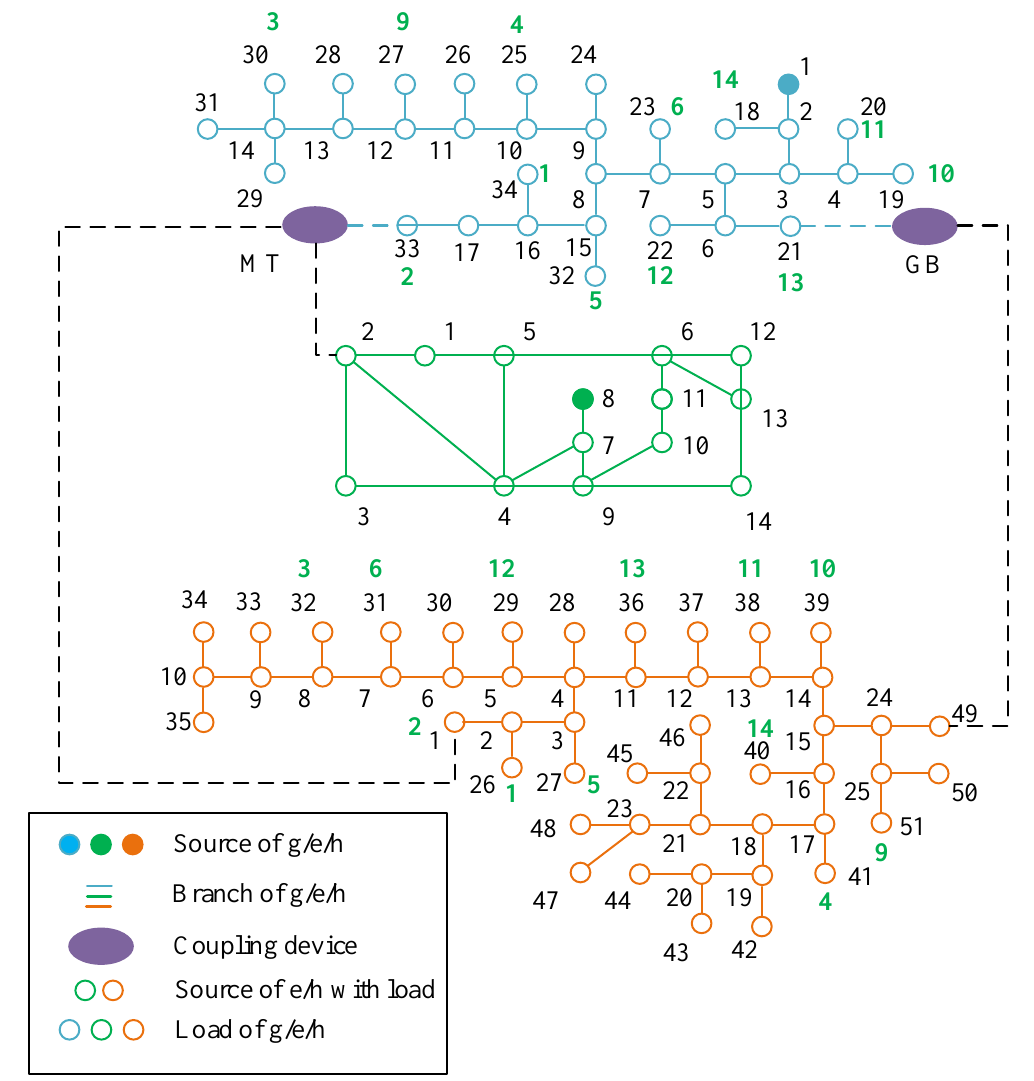
Figure 5. IES structure in this case.